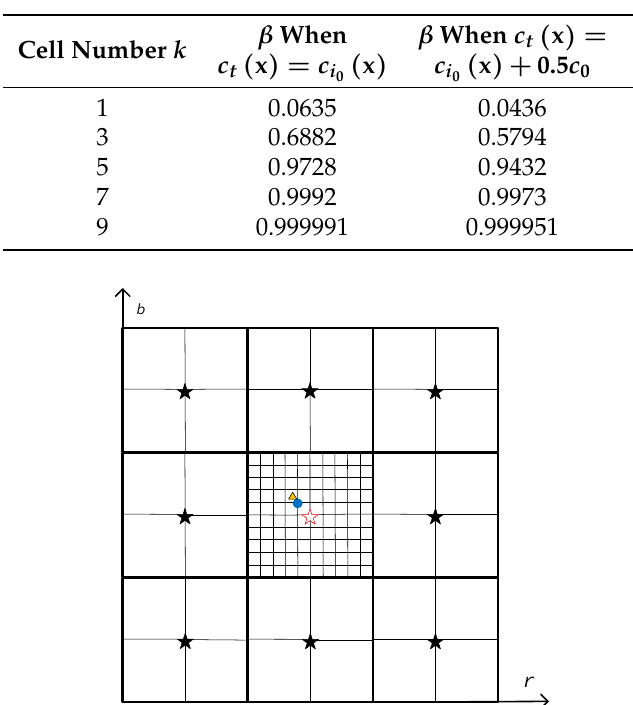
Table 1. The confidence level β under different cell number k when c t ( x ) = c i range, azimuth and Doppler cell of the target x is is located in the sampling position) and c t ( x ) = ( x ) + 0.5 c c i 0 (the corresponded range, azimuth and Doppler cell of the target x is is not located in the 0 sampling position with a offset 0.5 c 0 in each dimension).